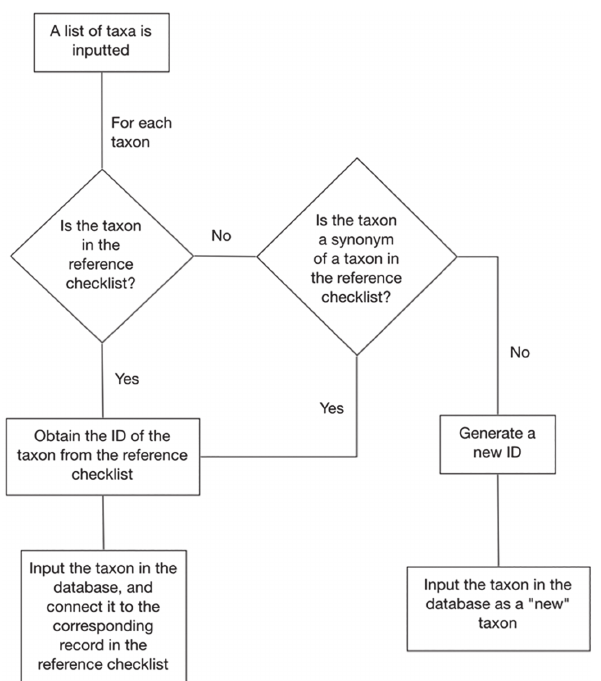
Fig 1. Input and storage of taxon names in the database of a portal. Once a list of names is inputted, the software checks whether the names match accepted names in the reference checklist, and stores them with their IDs in the checklist and in the database of morphological traits. Non-matching names are reported, and can be manually related to accepted taxa when they are synonyms, or inputted as “ new taxa ”